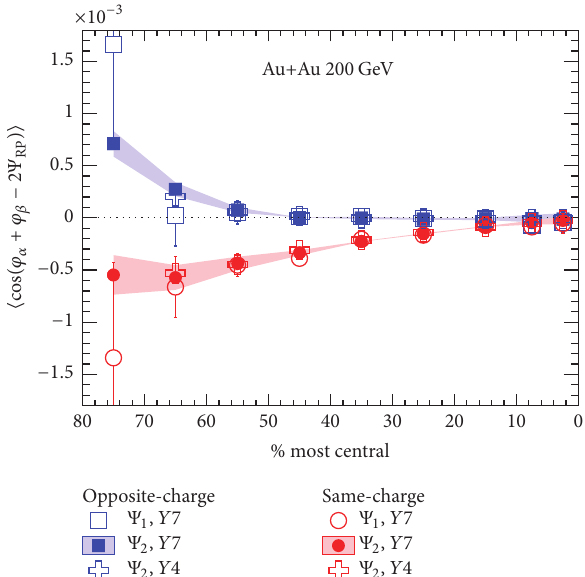
Figure 5: Three-point correlator, 𝛾 , measured with 1st and 2nd harmonic event planes versus centrality for Au+Au collisions at √𝑠 NN = 200 GeV [45]. Shown with crosses are STAR previous results from the 2004 RHIC run [46,